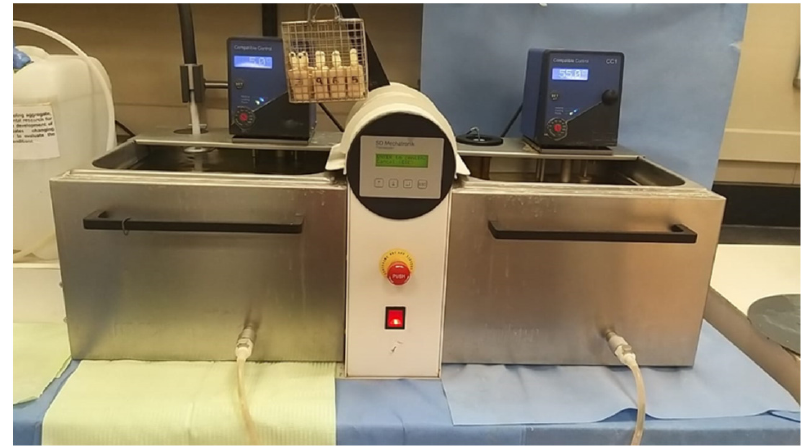
Figure 5. Thermocycling of cemented provisional crowns (5000 cycles between baths held at 5 °C and 55 °C).